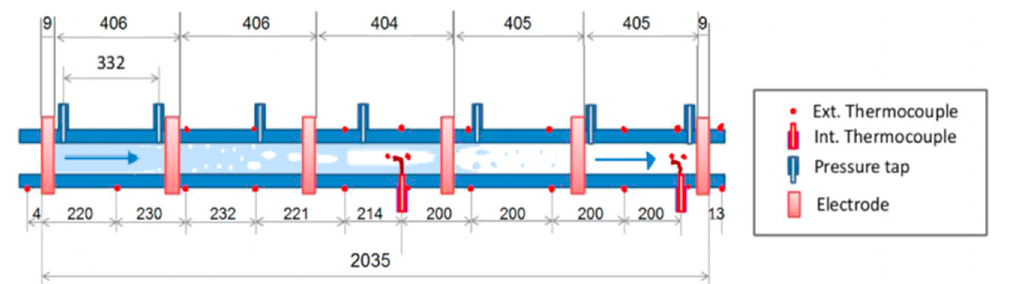
Figure 2. Schematic representation of the test section .